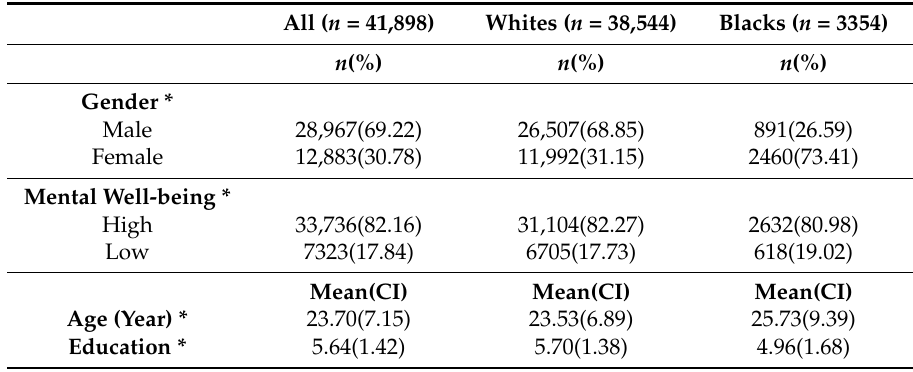
Table 1. Descriptive statistics overall and by race.